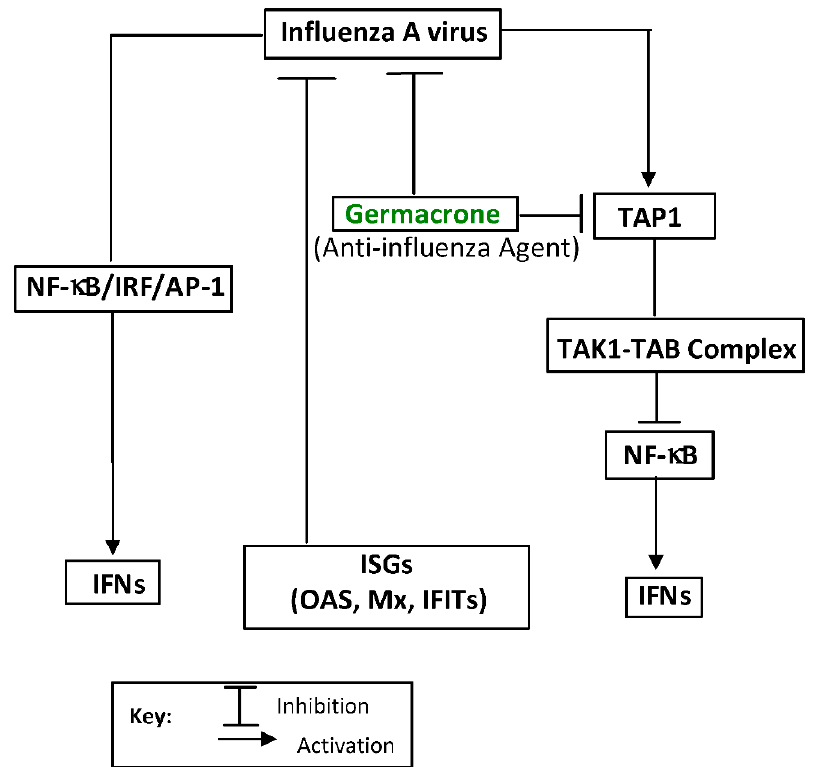
Figure 5. Inhibition of TAP1 expression (pathway inhibition) by germacrone, a lead antiviral essential oil compound against the influenza A (H1N1) virus, and its replication: a mechanism of action. Nuclear factor kappa-light-chain-enhancer of activated B cells (NF- κ B), interferons (IFNs), and interferon regulatory factors (IRFs) regulate many aspects of innate and adaptive immune responses, including driving anti-viral responses. Interferon stimulating genes (ISGs) are critical effectors of IFN response to viral infection. Transcription factor (AP-1) regulates the inflammatory gene expression in response to viral infections. The transporter associated with antigen processing 1 (TAP1), transforming growth factor- β -activated kinase 1 (TAK1), and TAK1 binding protein (TAB) are also involved. The illustration was adapted from Li et al. [147] and redrawn with copyright permission by © Elsevier BV, The Netherlands, 2020. Some anti-influenza active bisabolane-type sesquiterpenoids from turmeric oil ( Curcuma longa ) have also been reported [150]. Generally, turmeric oil is used in eth- nomedicine for the treatment of flu-related and/or airway inflammatory diseases, such as bronchitis, pneumonia, and influenza [151]. The compounds significantly acted as pathway inhibitors against the influenza A/PR/8/34 (H1N1) virus replication in MDCK and A549 cells in vitro [150]. The compounds act by inhibiting the expression of pro-inflammatory cytokines (IL-6, IL-8, IP-10, and TNF- α ), and regulating the activity of the NF- κ B/MAPK and RIG-1/STAT-1/2 signaling pathways [150]. The presence of ketone, α , β -unsaturation, and presence of an electron-withdrawing group (OH, OCH 3 , NH 2 , SH, and halogens) have been reported to influence the bioactivity of this group of compounds (Figure 6)